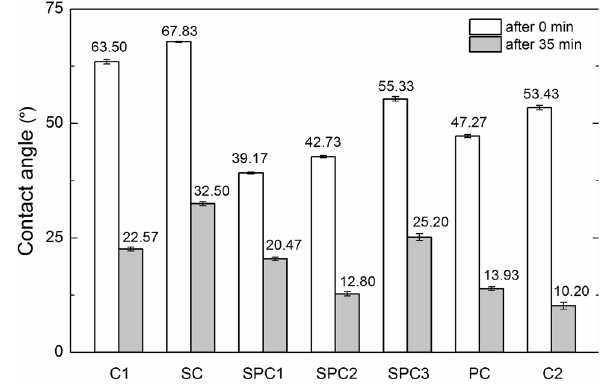
Fig. 13 Contact angle before F–T cycles after 0 and 35 min.